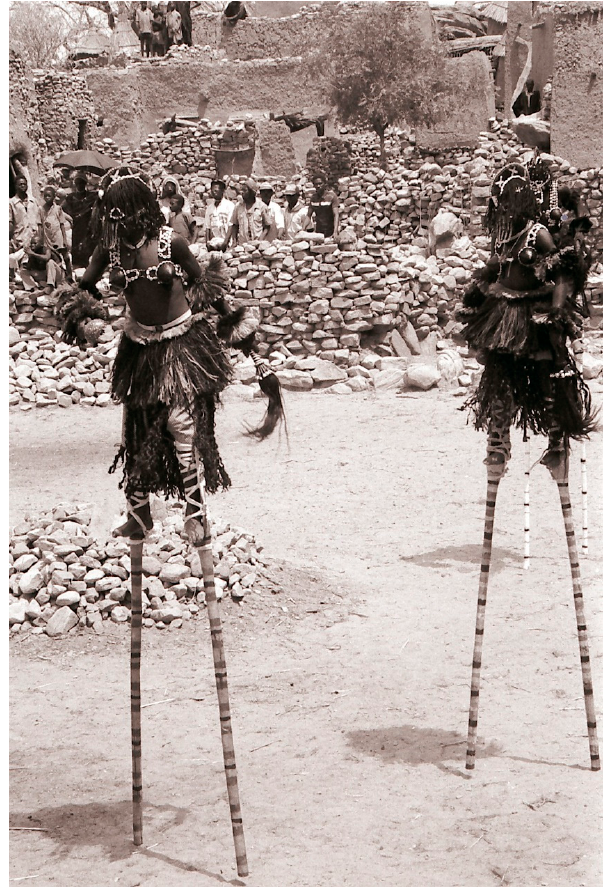
Figure 3. Tingetange performing.